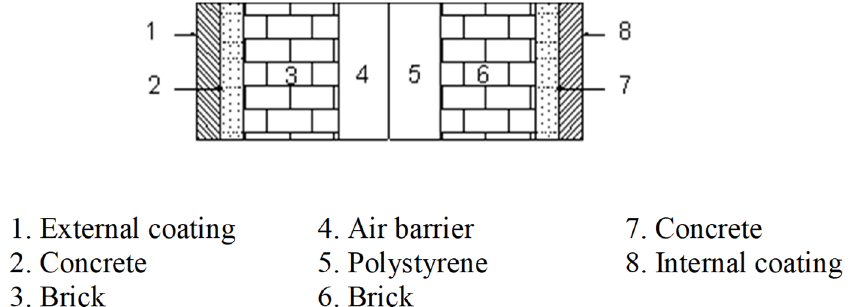
Figure 3. The concrete office building section.